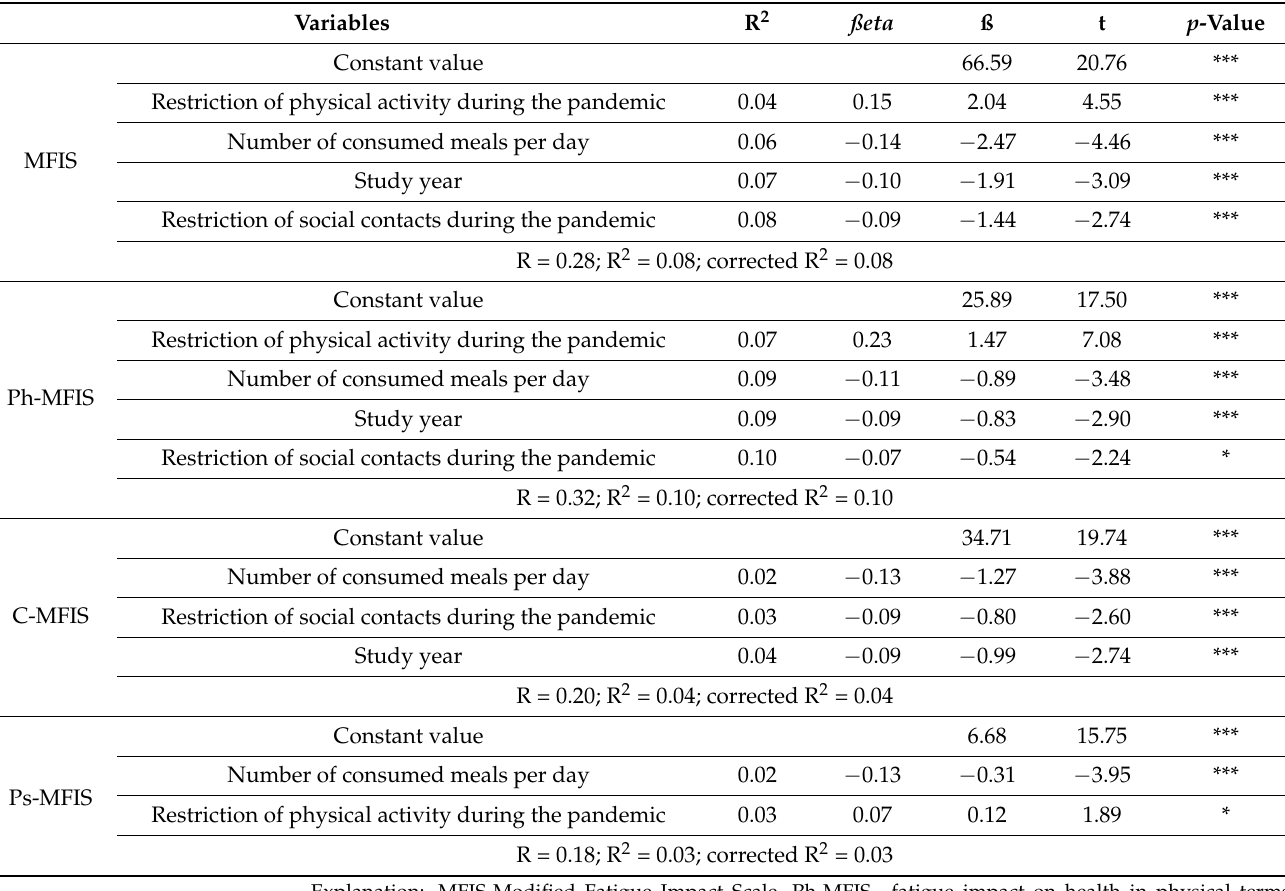
Table 4. The summary of regression-predictors of the impact of fatigue on health in general, physical, cognitive, and psychosocial